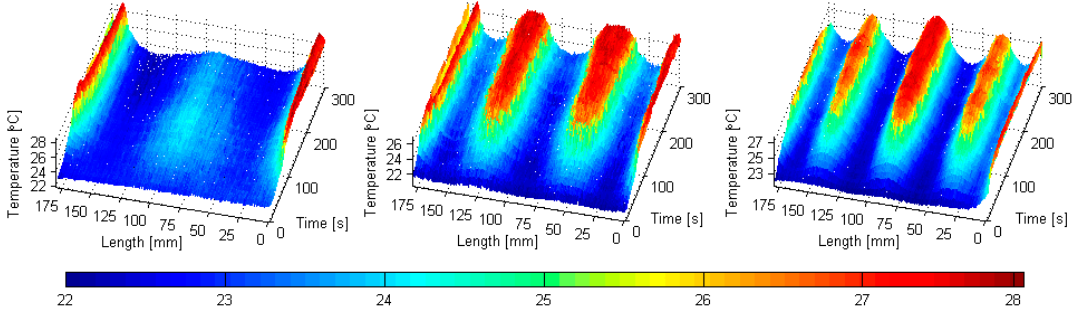
Figure 20. Evolution of longitudinal self-heating temperature profiles of PMC beams subjected to vibration at three first-resonant frequencies.